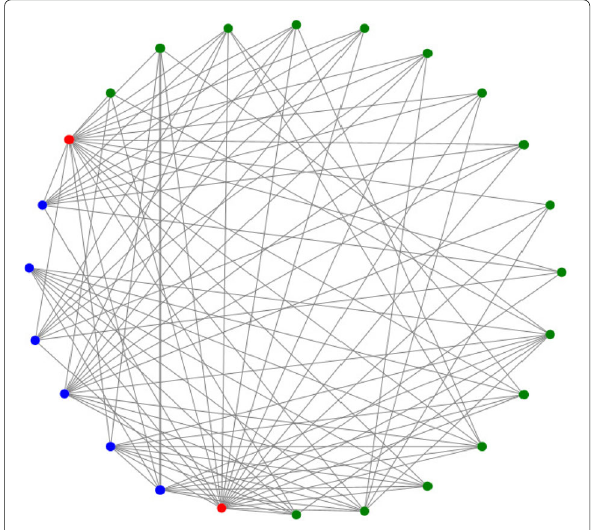
Fig. 7 The detected two communities in the Chesapeake and Florida Bay foodweb network. Blue nodes and green nodes represent two communities, respectively. The red nodes correspond to the intersection of the two